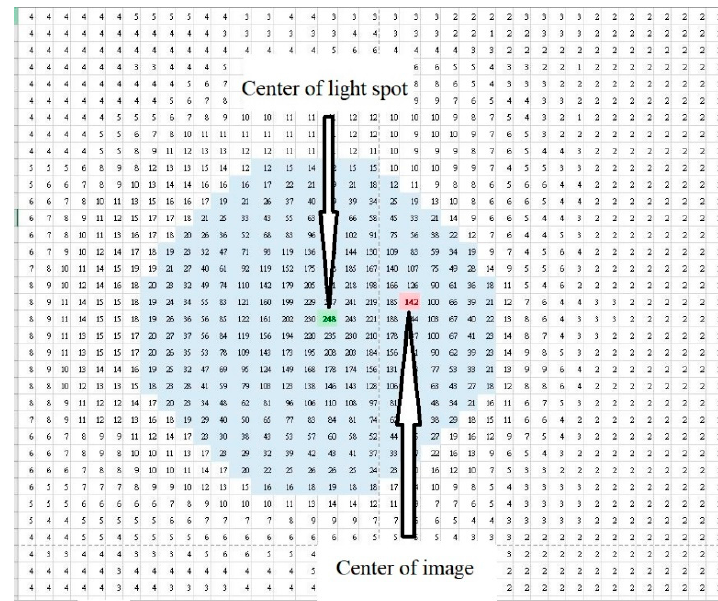
Figure 9. Complete light spot gray level histogram.